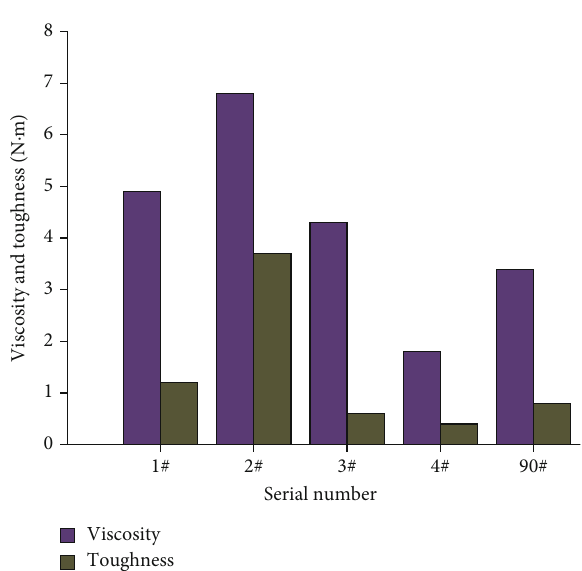
Figure 1: Column chart of the viscous toughness test of tire rubber powder-modi fi ed asphalt. The performance of 2# modi fi ed asphalt is signi fi cantly higher than that of other asphalt samples.